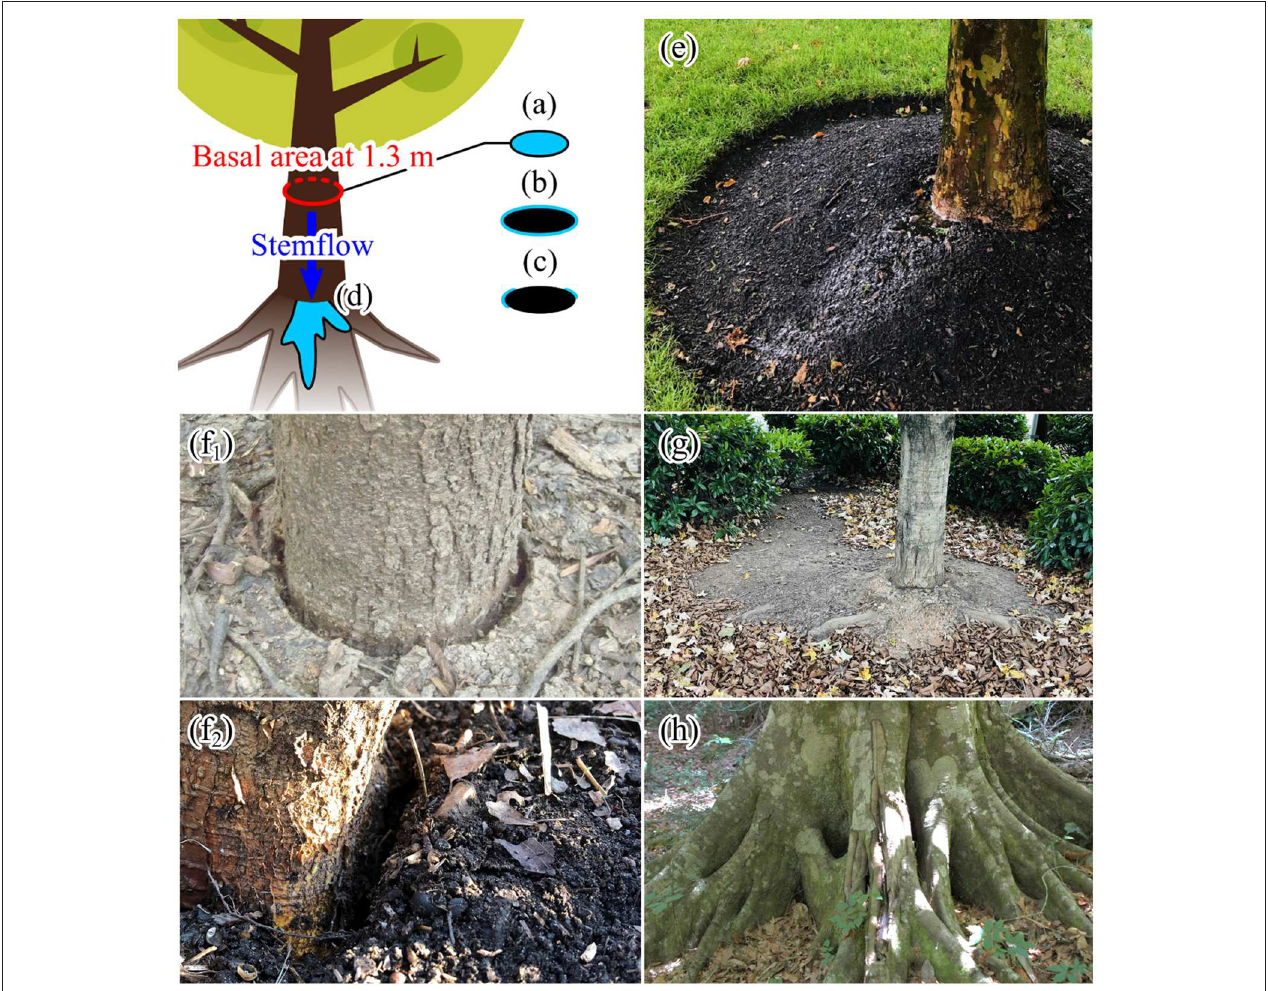
FIGURE 1 | Conceptualizations of stemflow infiltration area ( I T ), (a) represented as a function of stem basal area (Herwitz, 1986), (b) assumed equal to the minimum area around the stem that could transmit stemflow inputs (Gómez et al., 2002), (c) inferred from localized stemflow pathways given assumed saturated conductivity rates ( Imamura et al., 2017; Carlyle-Moses et al., 2018), (d) inferred empirically from photographed, video-recorded, and scour-based observations (this study, from scarce empirical observations in Table 1 ), and (e) example photograph of infiltrating stemflow (note that this is a planted tree with artificial surface cover). (f 1 ,f 2 ) When a gap is present between the stem base and soils, it is reasonable to think that substantial stemflow infiltration may occur immediately beside the stem. Alternatively, (g) litter scour marks suggest large stemflow infiltration areas or (h) wide root bases may provide physical impediments to infiltration and, thus, we would expect infiltration areas to be larger (photos by